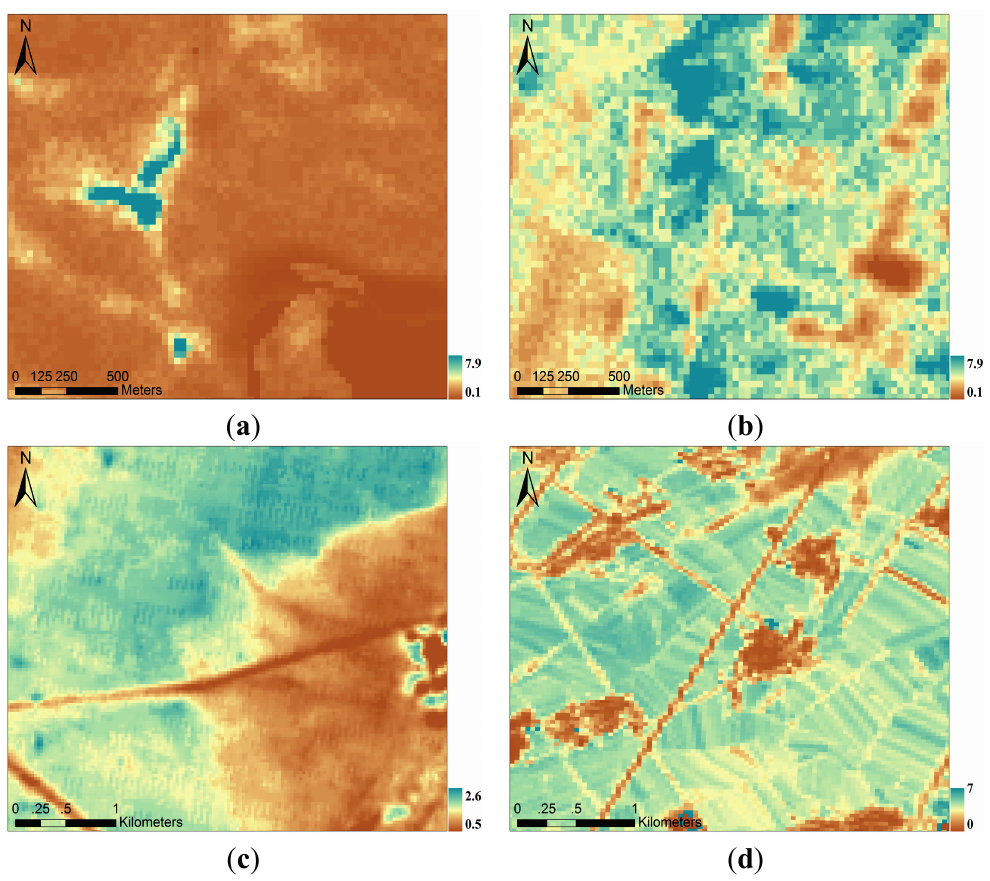
Figure 2. LAI reference maps of each site: ( a ) June 2012, Dayekou; ( b ) June 2012, Yingke; ( c ) July 2013, Hulunber; and ( d ) July 2013,